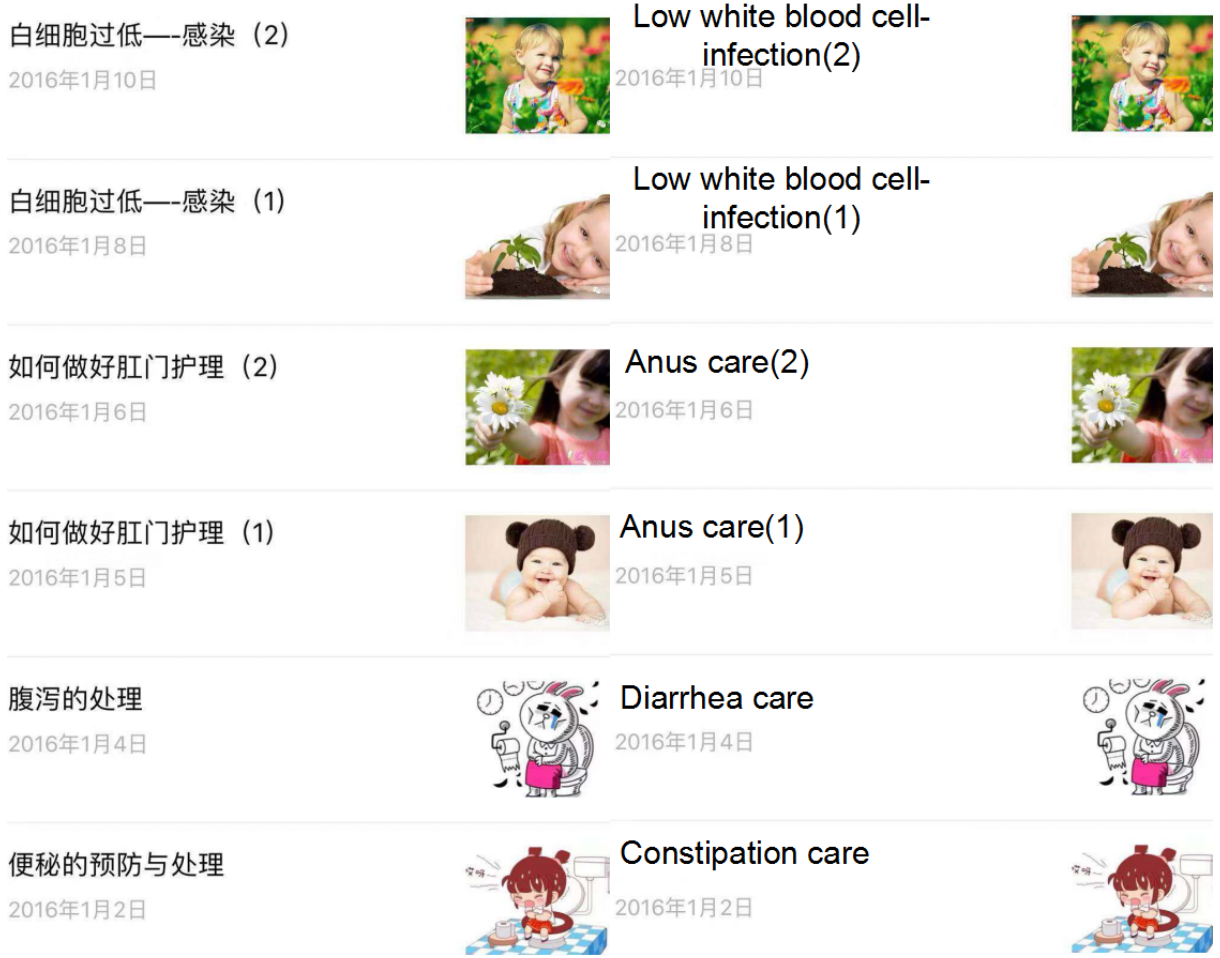
Figure 2. WeChat Official Account health education article